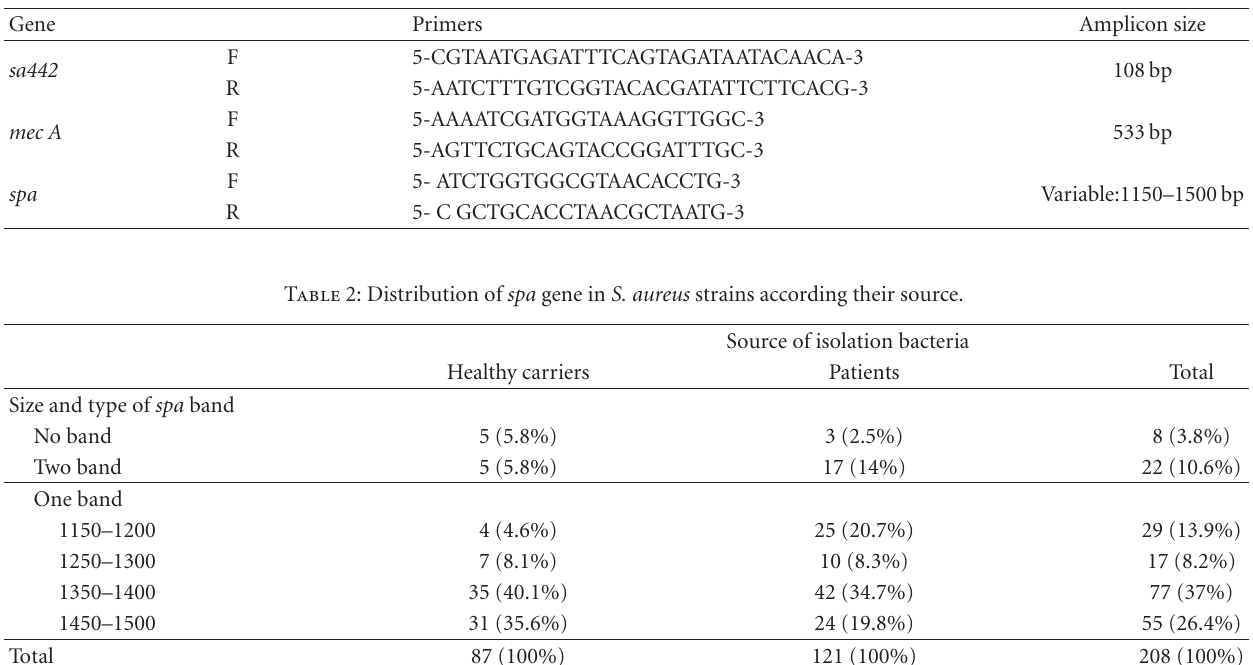
Table 1: The genes and related primers used in this study.